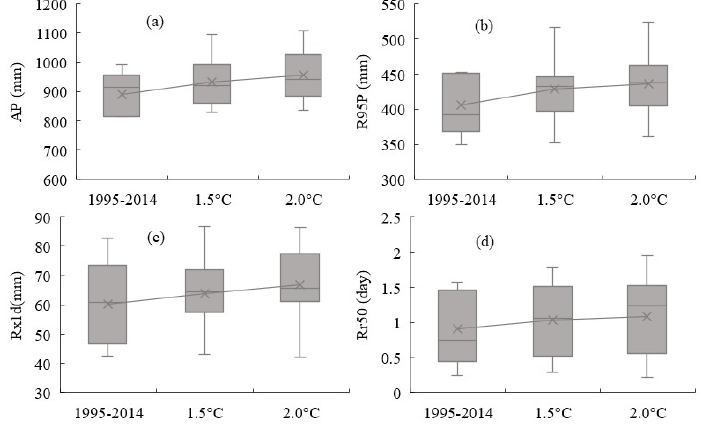
Figure 7. Quartile analysis on extreme rainfall indices in baseline period and time spans of 1.5 ◦ C and 2 ◦ C global warming ( a to d represent scenarios of SSP1-2.6, SSP2-4.5, SSP3-7.0, and SSP5-8.5 respectively) ( a – d ).